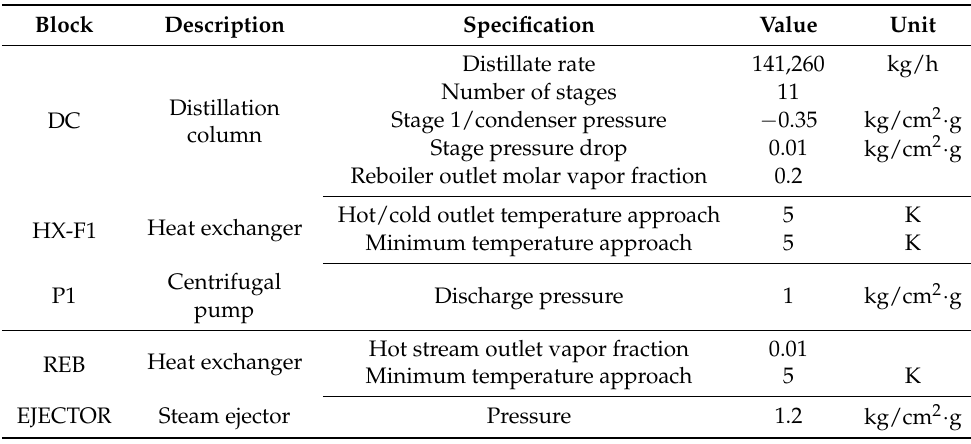
Table 3. Specifications of alternative process model using